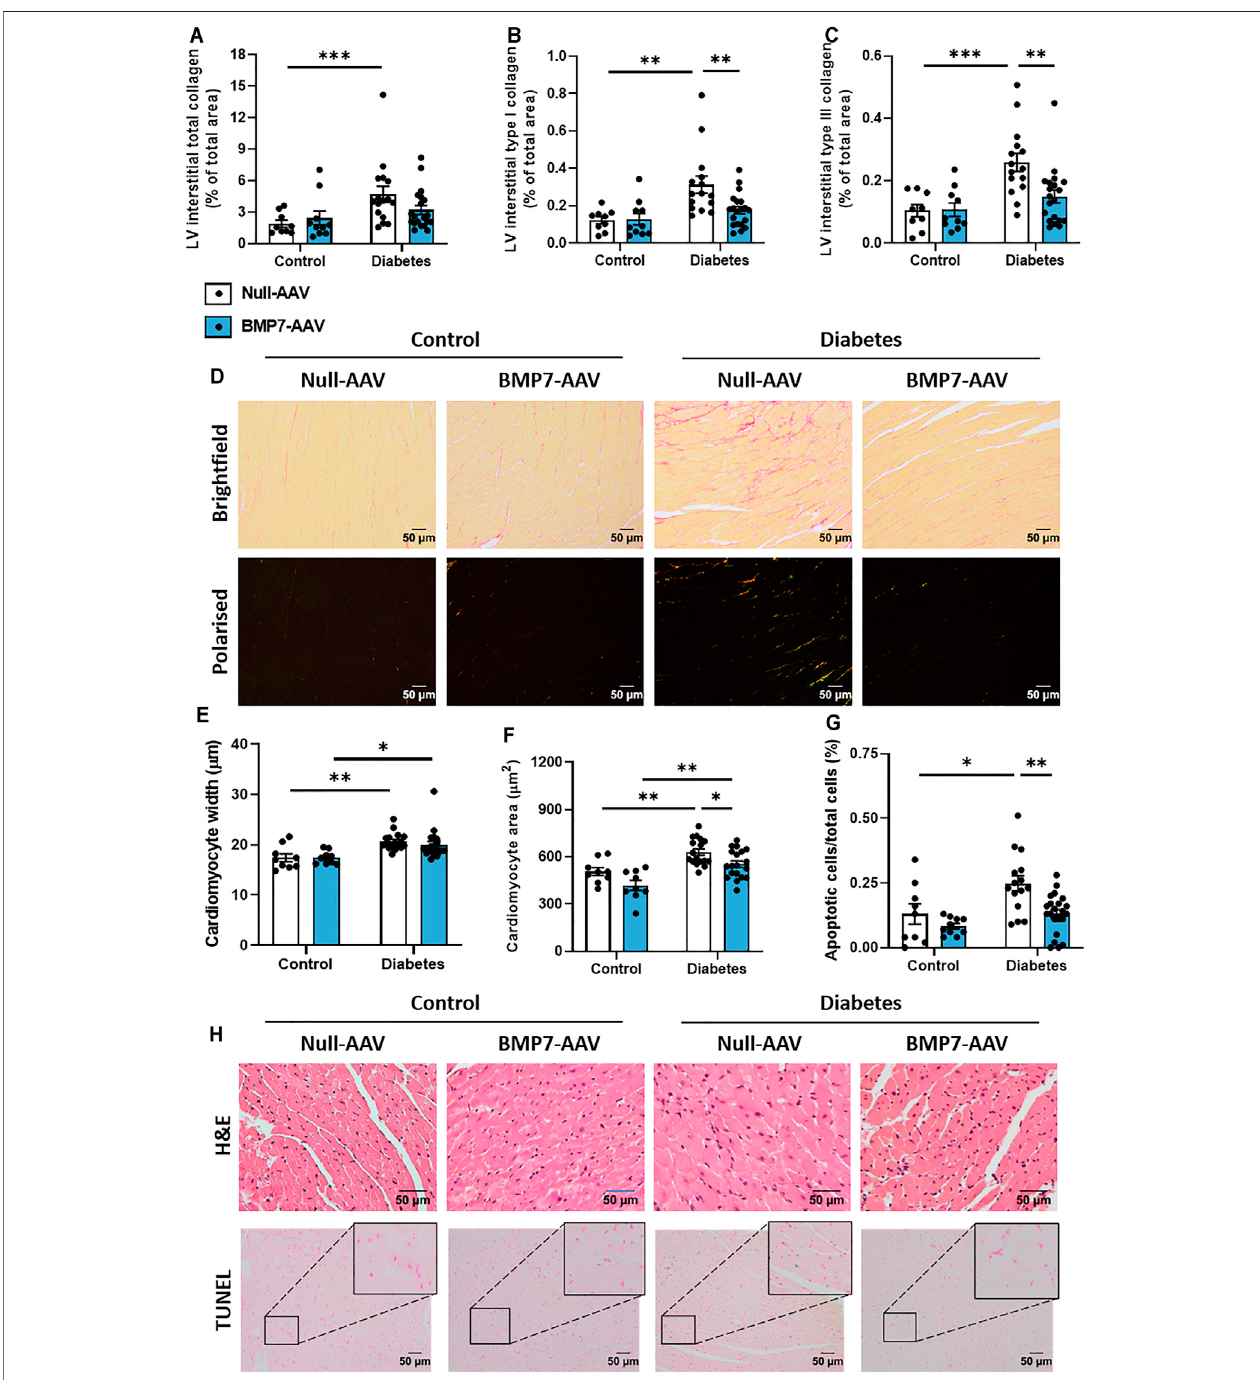
FIGURE3 | Theeffectof rAAV6-BMP7 gene therapy on diabetes-induced structural changes. Quanti fi cation of picrosirius red-stained LV cross sections. (A) Total interstitial collagen content using bright fi eld imaging, interstitial type I (B) and type III (C) collagen content using polarised light. (D) Representative images of picrosirius red-stainedcollageninLVcrosssections(toppanel,bright fi eld;bottompanel,polarisedlight;scalebar:50 µm).Quanti fi cationinLVcrosssectionsof (E) cardiomyocyte width and (F) cardiomyocyte area inhaematoxylinand eosin-stained samples,and (G) TUNEL-positiveapoptotic cells. (H) Representative images ofhaematoxylin and eosin-stained LVsections (toppanel) andTUNEL-positiveapoptotic cells(bottom panel;scalebar:50 µm).Dataarepresented asmean ± SEM. n (cid:1) 9 – 20per group (see individual data points). * p < 0.05, ** p < 0.01, *** p < 0.001. Two-way ANOVA followed by Tukey ’ s post hoc test. AAV, adeno-associated virus; BMP7, bone morphogenetic protein 7; H&E, haematoxylin & eosin; LV, left ventricle.